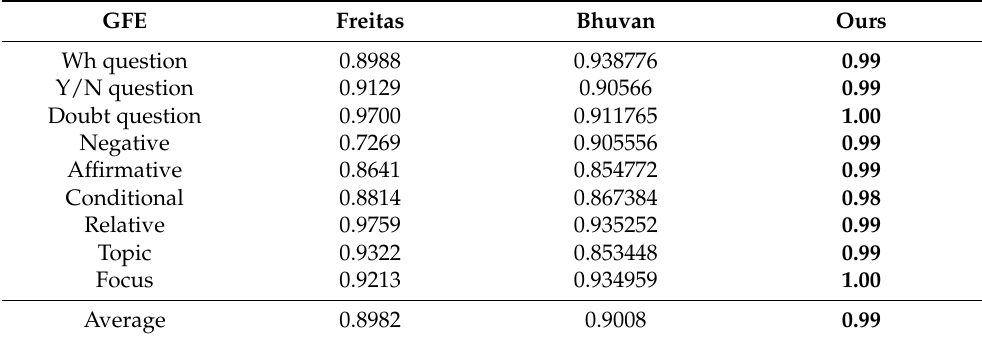
Table 4. F1 scores achieved by our proposed model and other state-of-art approaches using a dataset storing grammatical facial expressions of the Brazilian sign language (Libras) made by subject two. Best results are in bold.